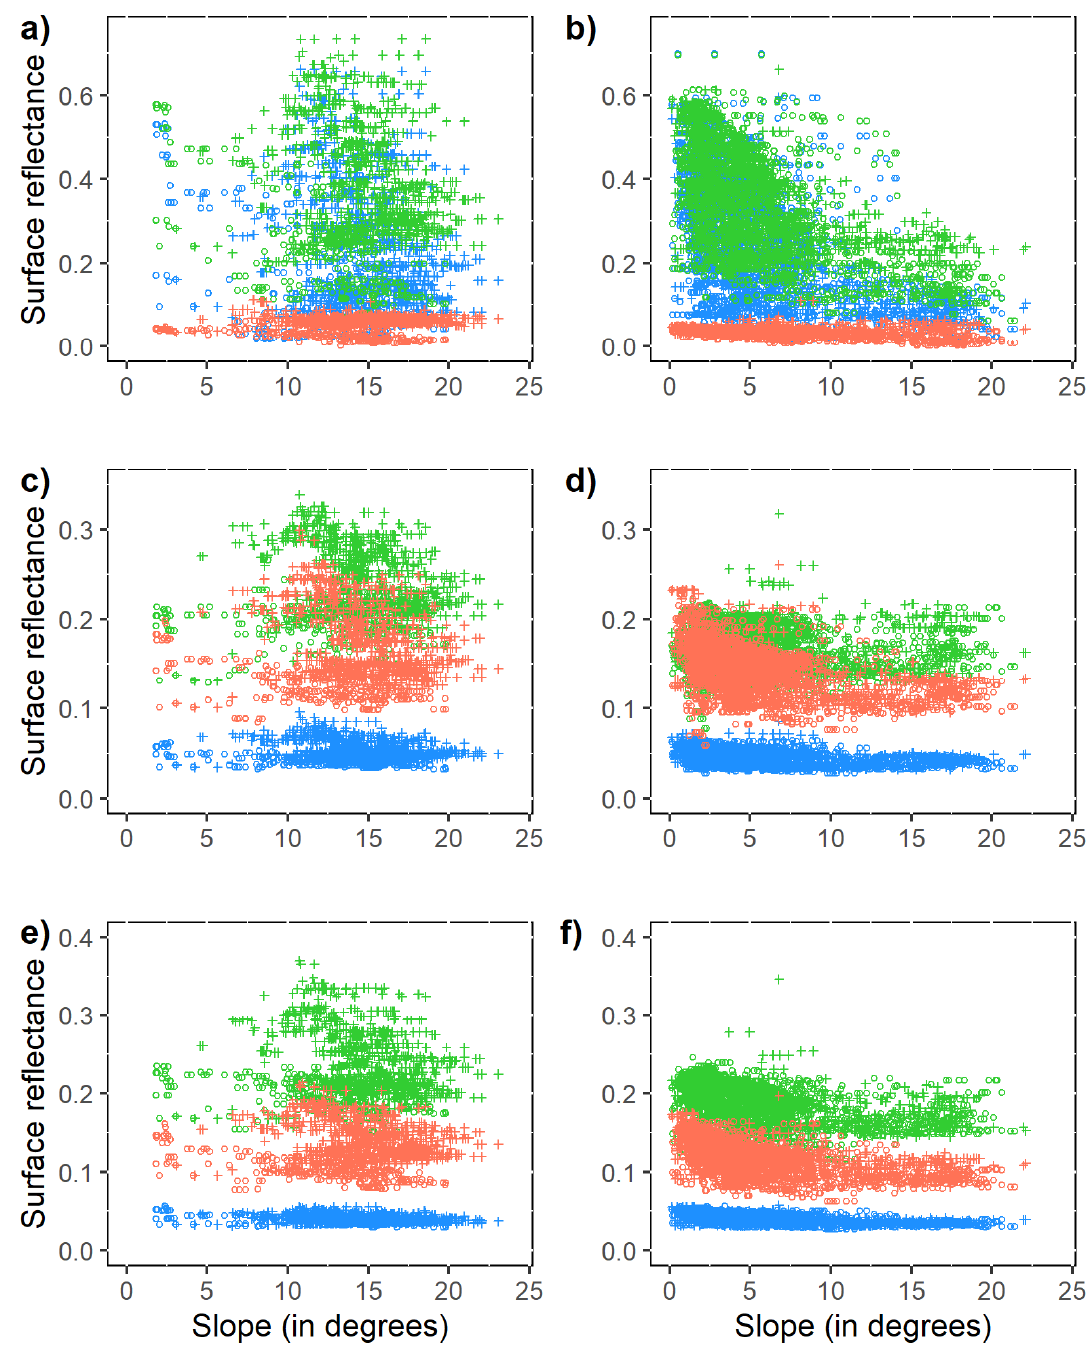
Figure 9. Relationships between surface reflectance (visible band in blue, near-infrared band in green, and shortwave infrared band in orange) and slope in March (upper panel), May (middle panel), and August (lower panel) 2014. Trees in the northern aspect are represented by an open circle, and in the southern aspect, by a cross symbol. Sub-plot ( a , c , e ) are for deciduous forests, while sub-plot ( b , d , f ) are for evergreen forests.